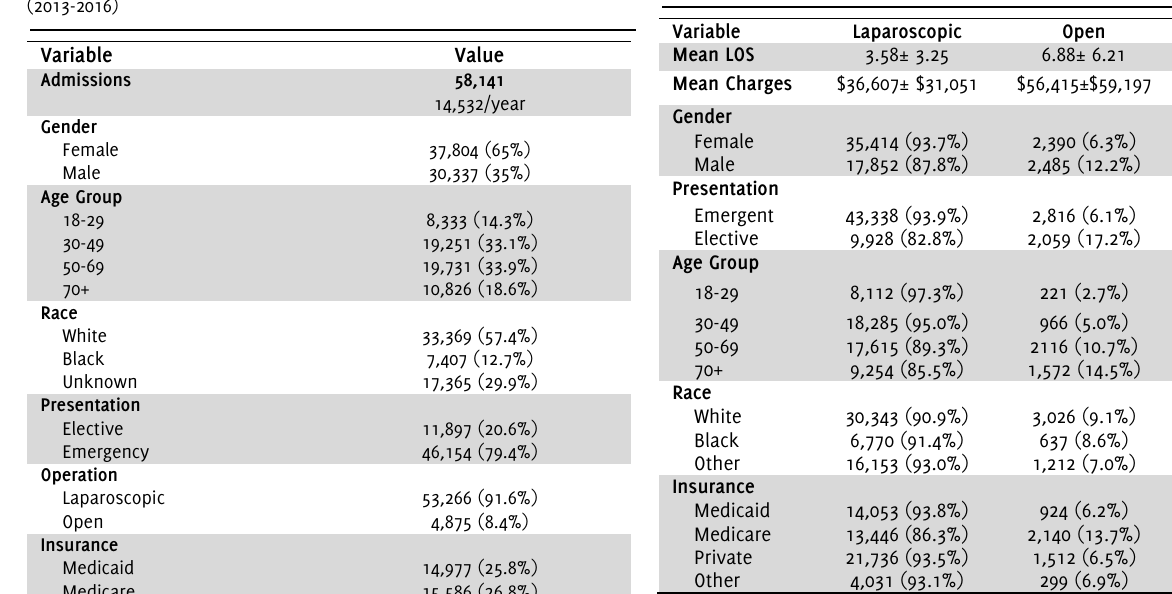
Table 4. Cholecystectomy Patient Characteristics By Procedure